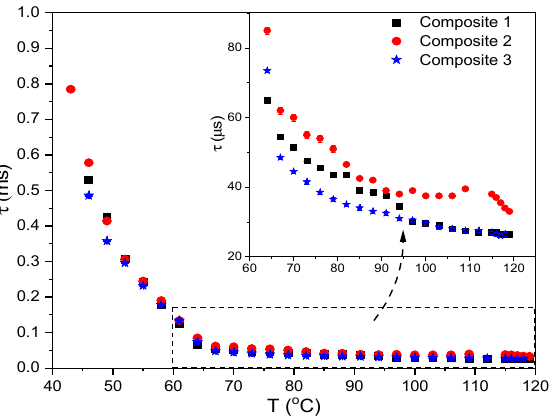
Figure 11. Temperature dependence of the switching time, f = 50 Hz, U = 120 V. The rectangular dashed area presents the SmC* A range at the inset.